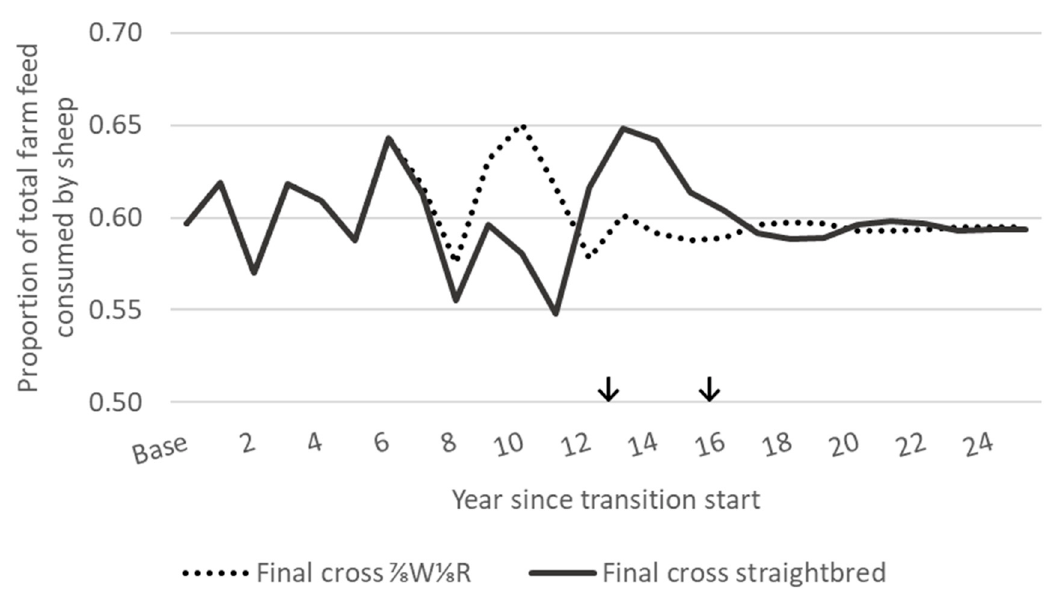
Figure 5. Proportion of total farm feed supply consumed by sheep, constrained between 0.55 and 0.65 of total farm feed supply, for a grading up transition from base Romney to a desired final cross of either 7 / 8 W 1 / 8 R or straightbred. ↓ Where the grading up transition period has finished and the desired